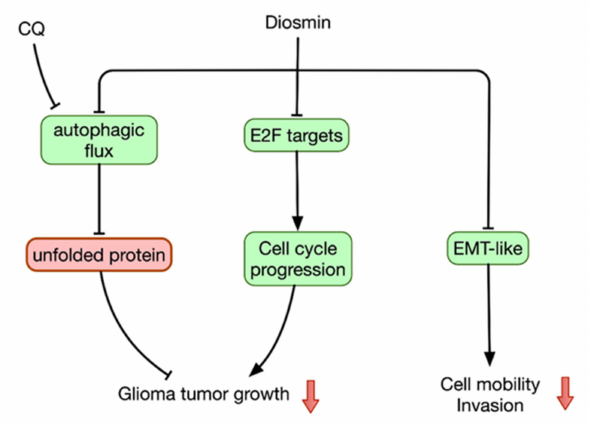
Figure 10. Proposed model for anti-glioma mechanism of diosmin. EMT-like, epithelial-mesenchymal like